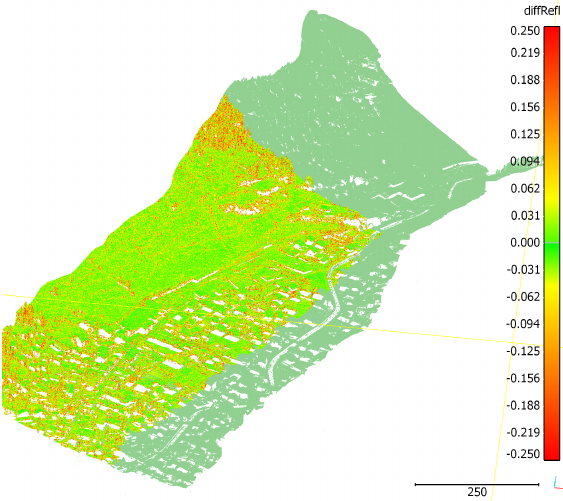
Figure 5: ALS point cloud of Figure 2, colour-coded by the abso- lute difference in diffuse reflectance value for overlapping flight